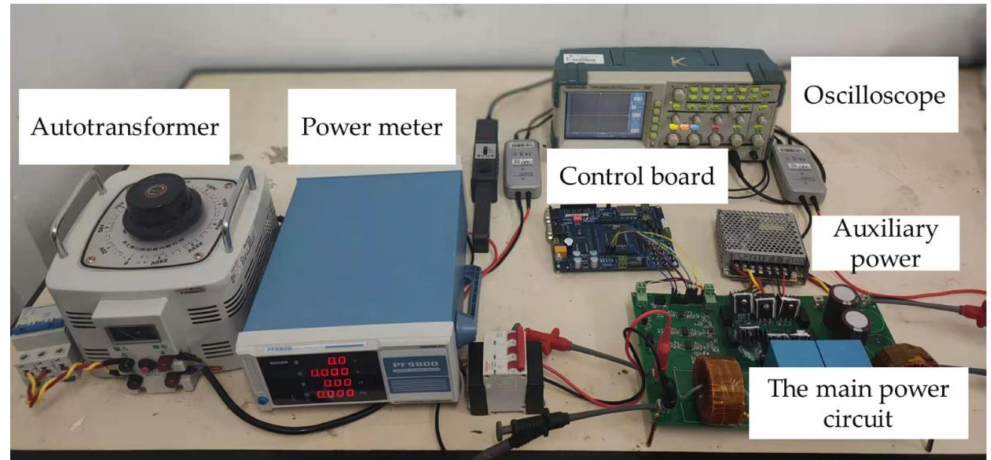
Figure 14. The photo of the experimental